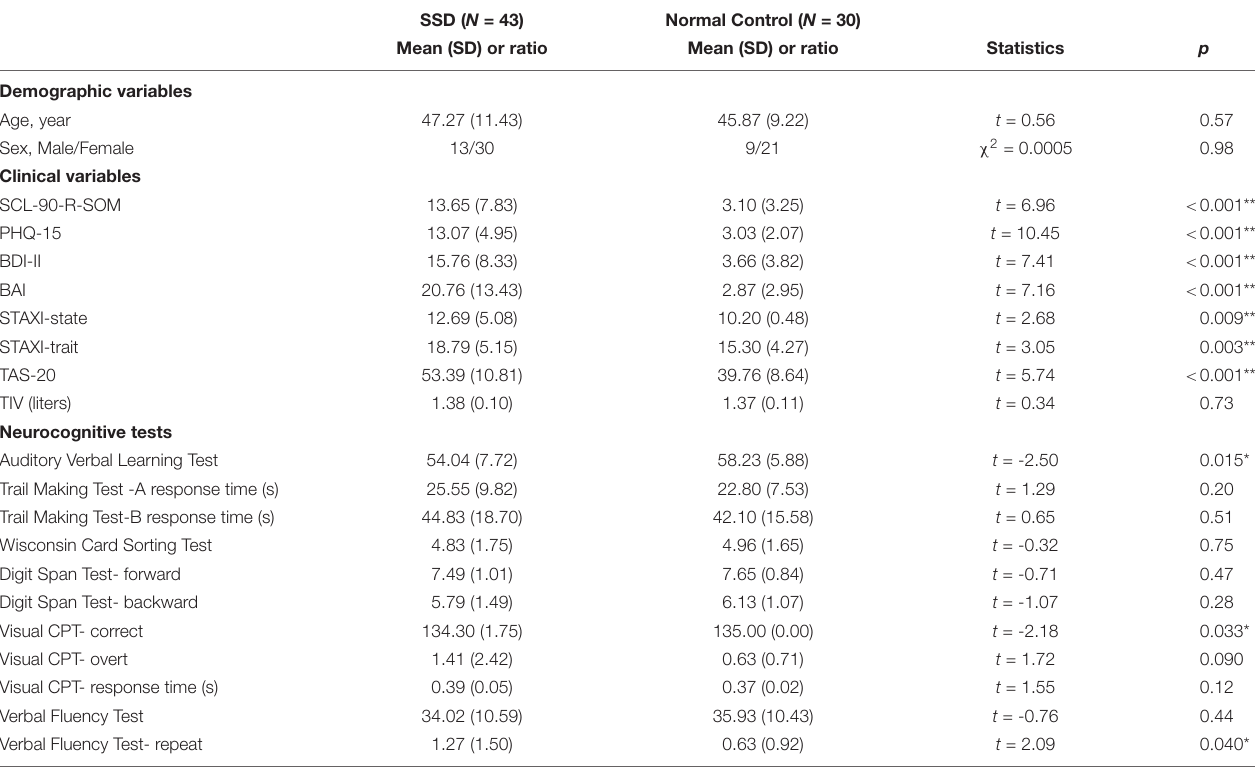
TABLE 1 | Demographic and clinical characteristics, and results of neurocognitive